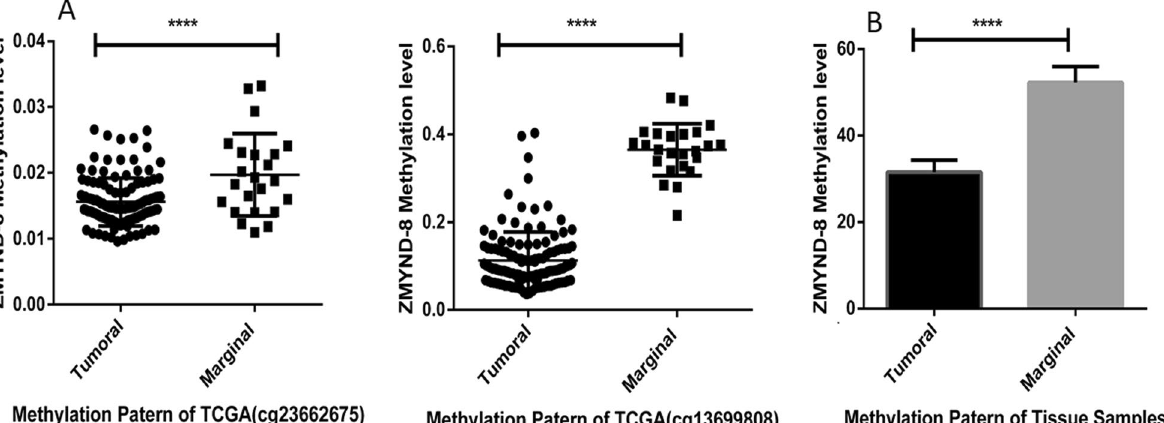
Fig. 1 A ZMYND-8 methylation pattern of TCGA datasets. Comparison of ZMYND-8 overall methylation levels between NSCLC and normal samples